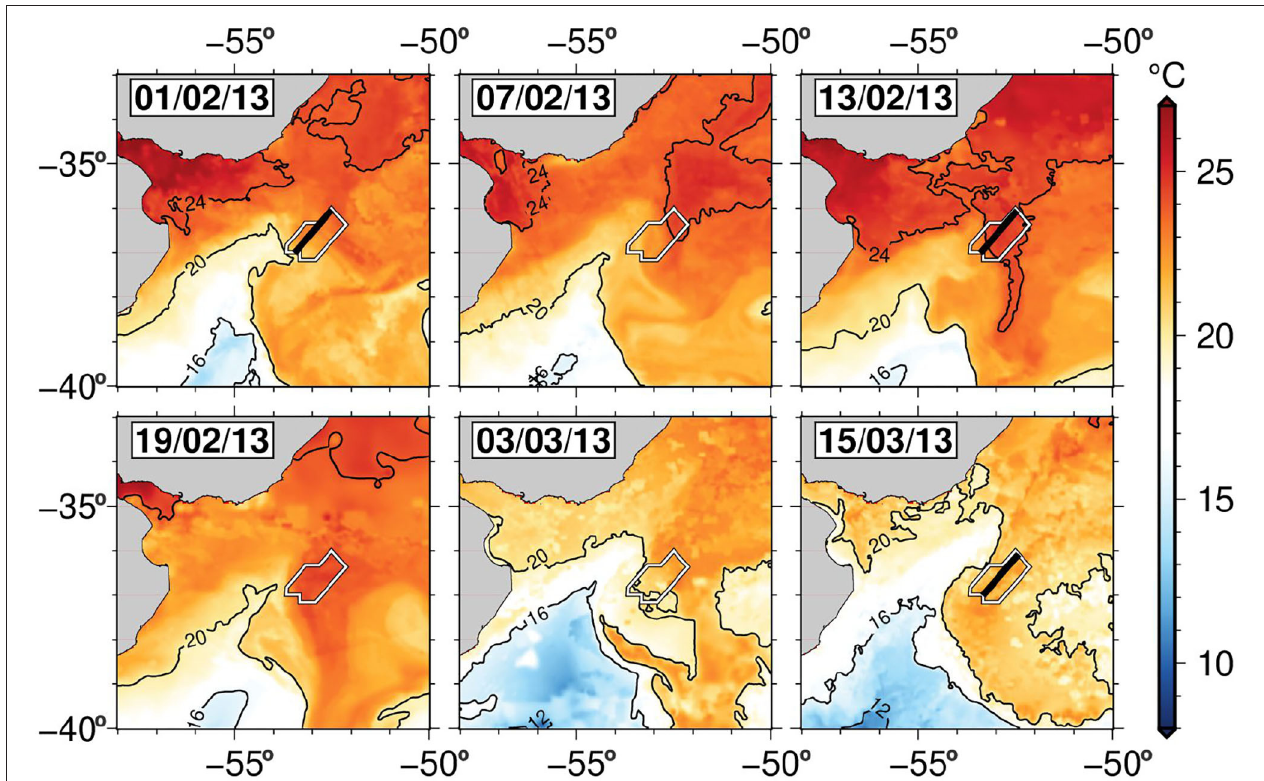
FIGURE 3 | Selected maps of sea-surface temperature for southwest Atlantic Ocean showing temporal variability of Brazil-Falkland Confluence. Red/blue colors = warm/cold sea surface temperatures from 1st February 2013 to 15th April 2013 (date shown at top left-hand side). Satellite sea-surface temperature observations from L4 gridded products of GHRSST database that have daily and 1 km resolutions. White polygon = location of 3D seismic survey; thick black line = loci of seismic sections for 01/02/13, 13/02/13, and 15/03/13; thin black lines = sea surface temperature contoured at 4 ◦ C